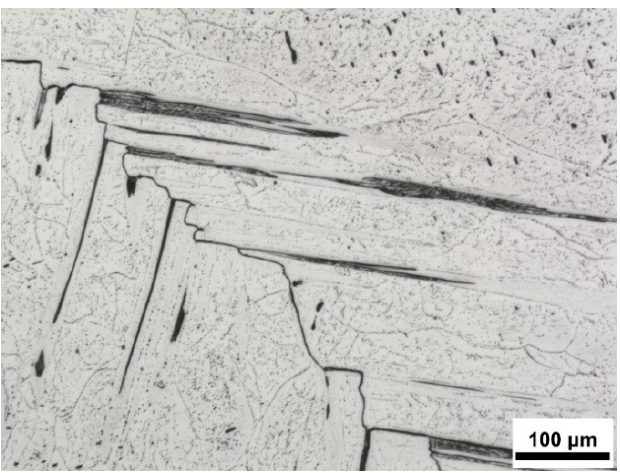
Figure 5. Original WA laths grew into both adjacent δ-ferrite grains. Nucleation of WA on a δ-ferrite grain boundary was accompanied by a local rotation of parts of the grain boundary to produce zig-zag morphology. LM.